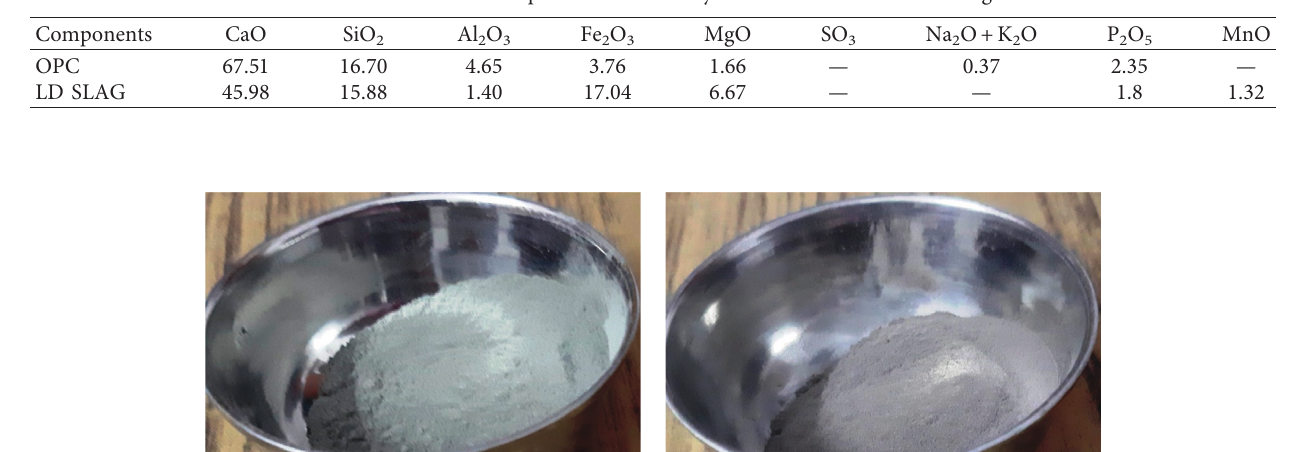
Table 1: Chemical composition of ordinary Portland cement and LD